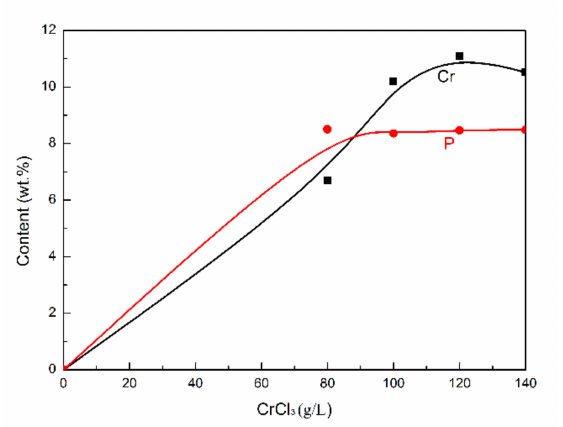
Figure 8. Relationship between the CrCl 3 concentration and composition of the alloy